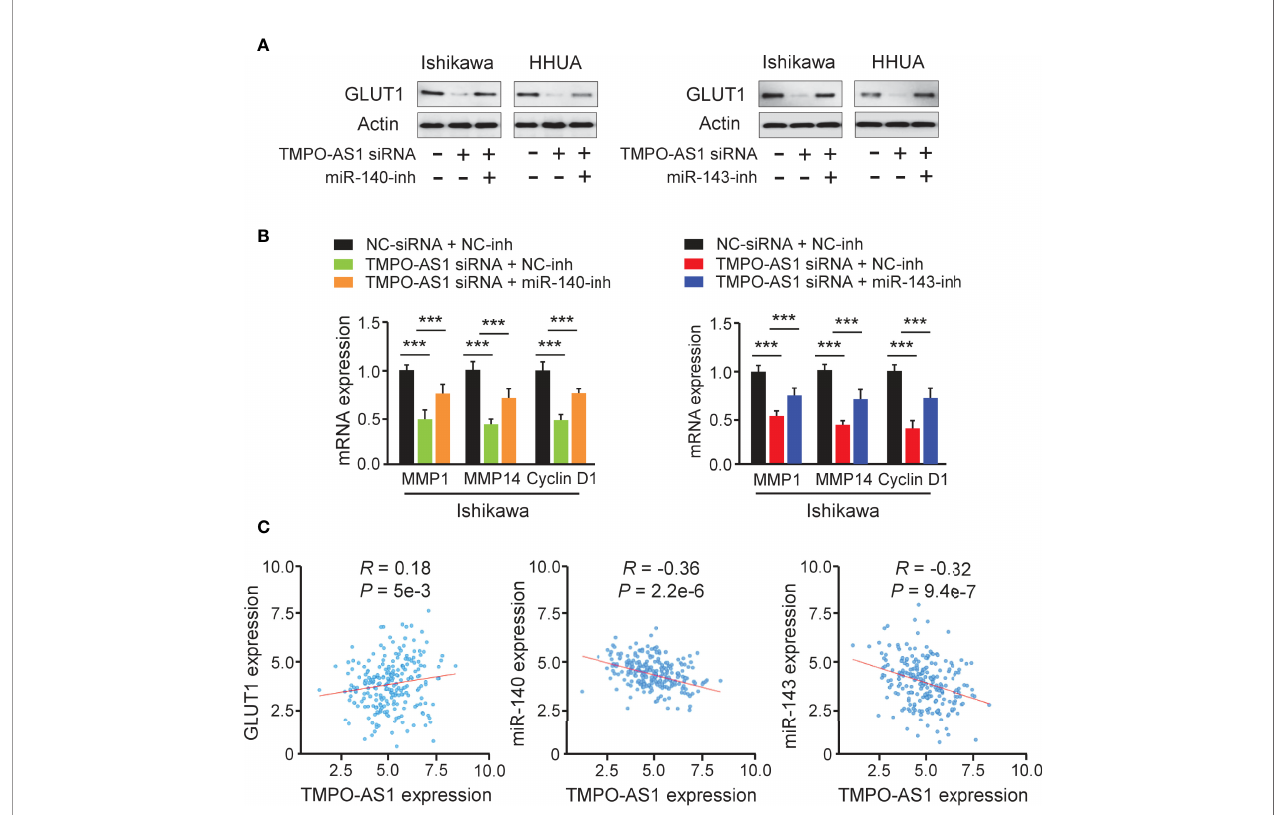
FIGURE 8 | TMPO-AS1 Induces GLUT1 Expression by Repressing MiR-140 and MiR-143 Levels. (A) GLUT1 protein expression was measured in Ishikawa and HHUA cells transfected with (or without) TMPO-AS1 siRNA, along with (or without) miR-140/miR-143 inhibitor. (B) Examination of MMP1 , MMP14 , and Cyclin D1 expression in Ishikawa cells transfected as indicated. (C) Correlation analysis between TMPO-AS1 and GLUT1 or between TMPO-AS1 and miR-140/miR-143. *** P <